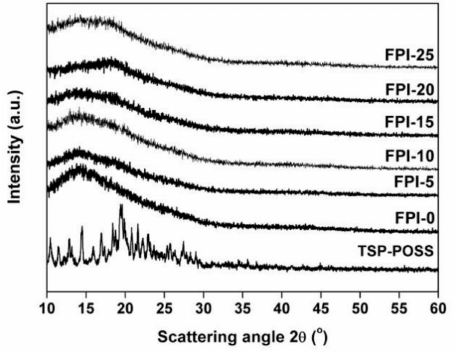
Figure 5. XRD plots of PI